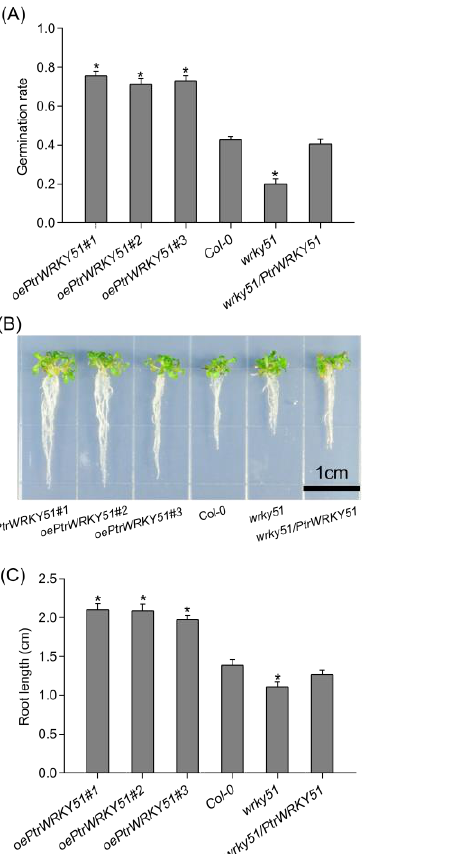
Figure 5. Overexpression of PtWRKY51 confers salt tolerance in Arabidopsis . ( A ) Difference in germination ratio among oe PtWRKY51 , Col-0, wrky51 , and wrky51 / PtWRKY51 plants grown on 1/2 MS medium with 200 mM NaCl. ( B ) Morphological comparisons of the primary root length for 10 d under 1/2 MS medium with 200 mM NaCl conditions. ( C ) Difference in the primary root length after 10 days of vertical growth on 1/2 MS medium with 200 mM NaCl conditions. ( D ) Morphological differences in salt treatments experiments. The data are represented as means ± SE ( n = 12). The asterisks (*) represent significant differences (* p < 0.05) compared to the control.